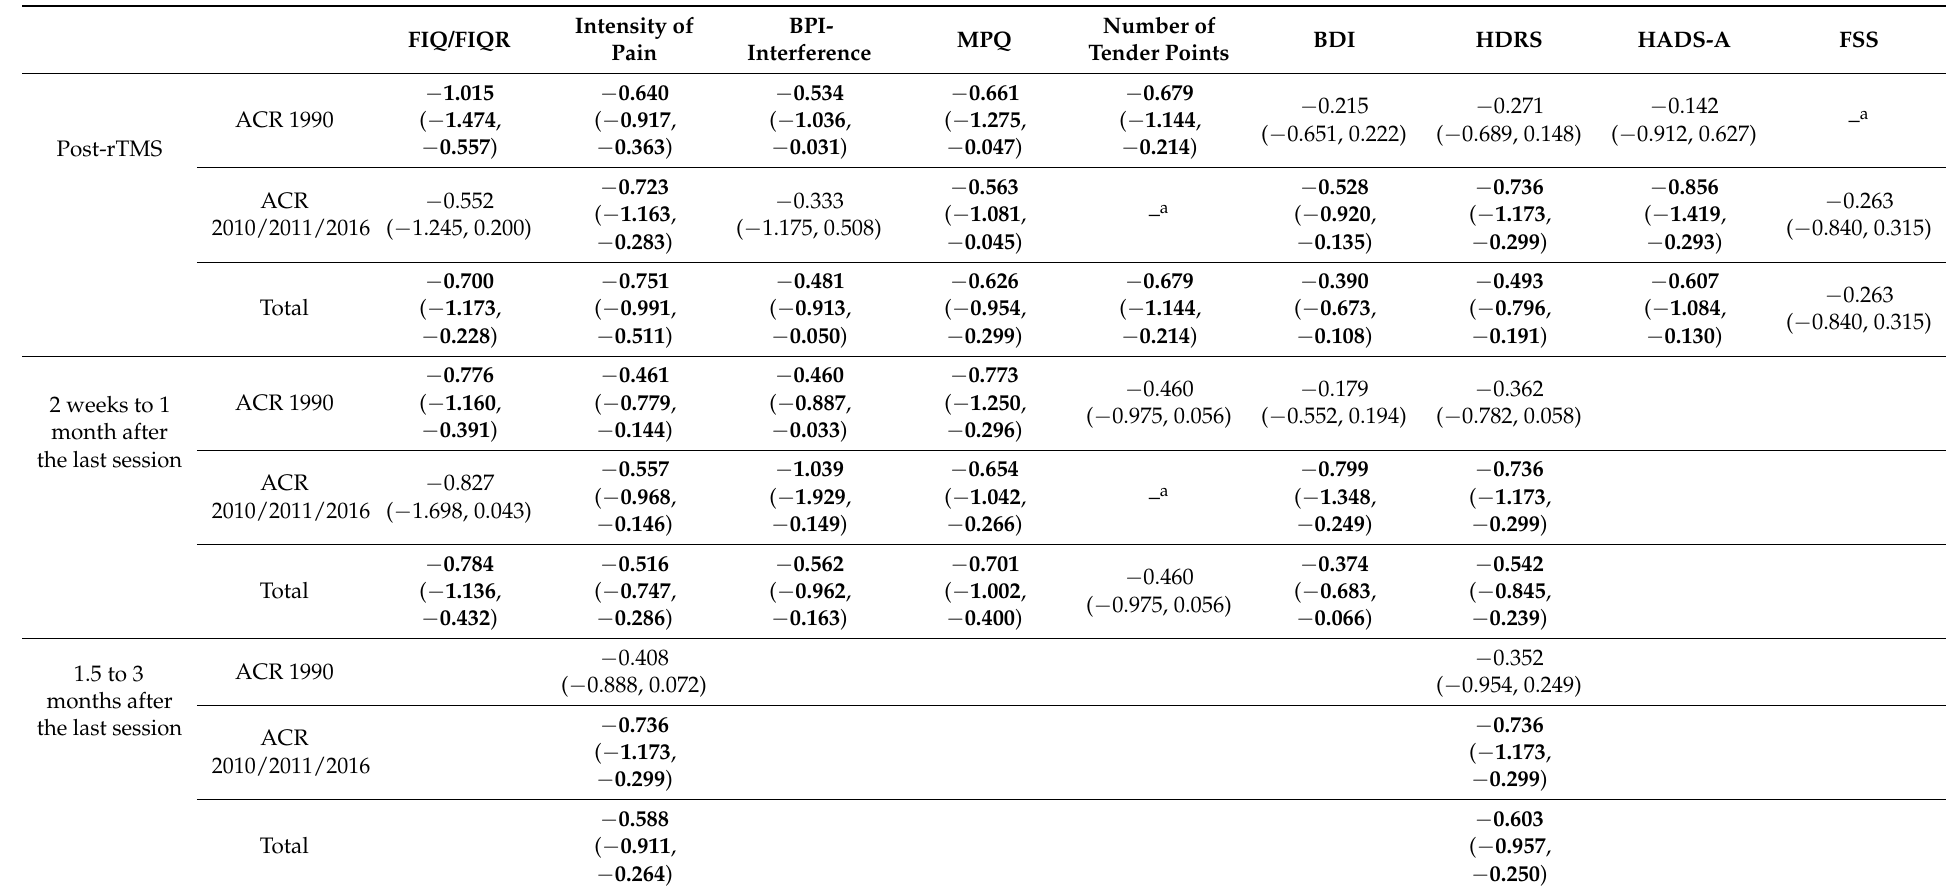
Table 4. Subgroup analyses by diagnosis